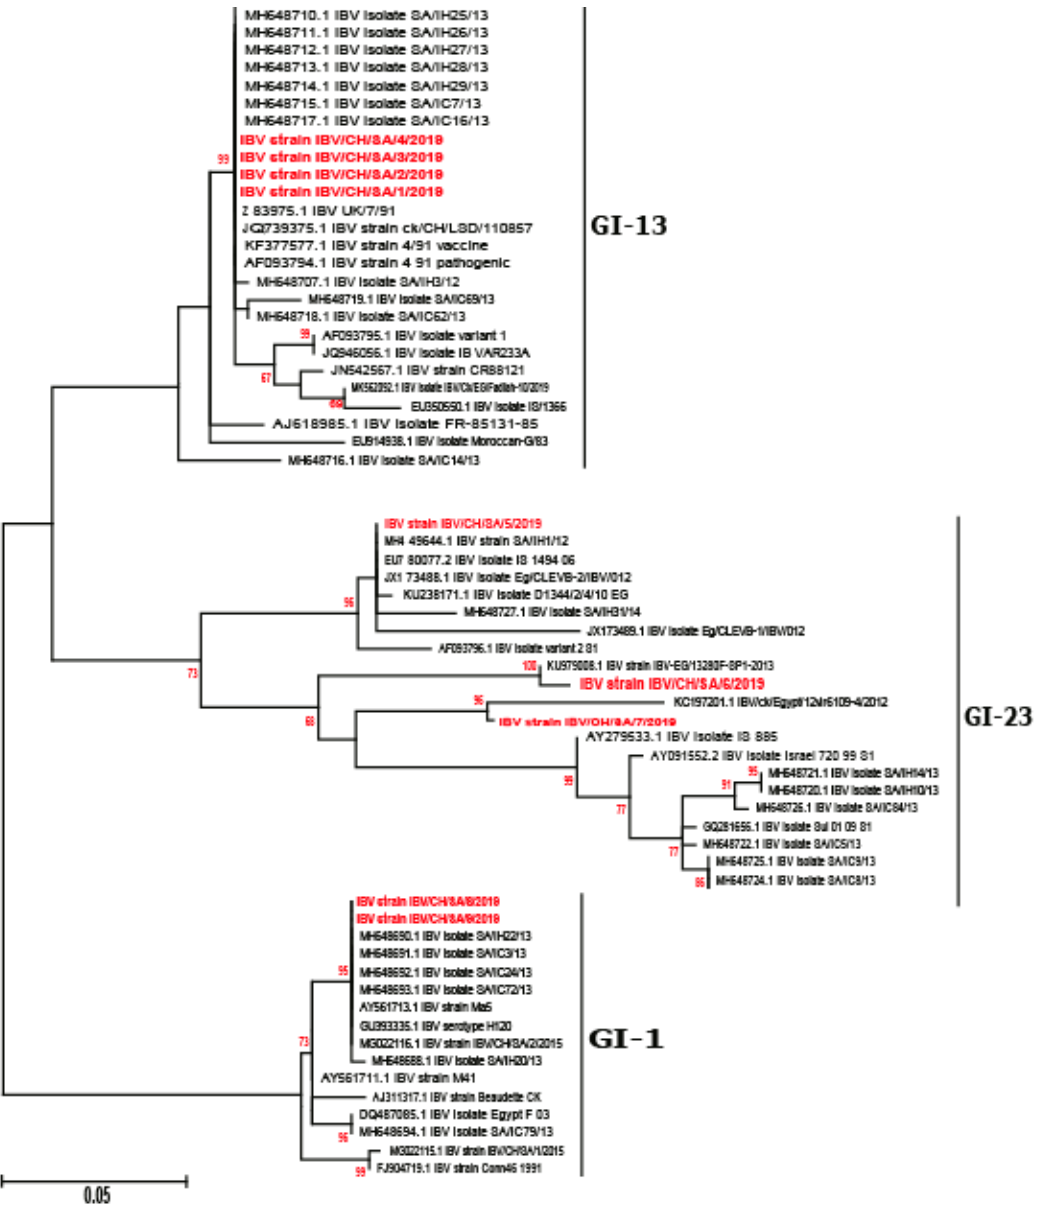
Figure 2. A higher resolution phylogenetic tree for GI-1, GI-13, and GI-23 lineages; the reported isolates are marked with red color. The robustness of individual nodes of the tree was assessed using 1000 replications of bootstrap resampling of the originally aligned nucleotide sequences. The scale bar represents the number of substitutions per site. The year of isolation and geographical origin of the virus sequences are included in the tree.